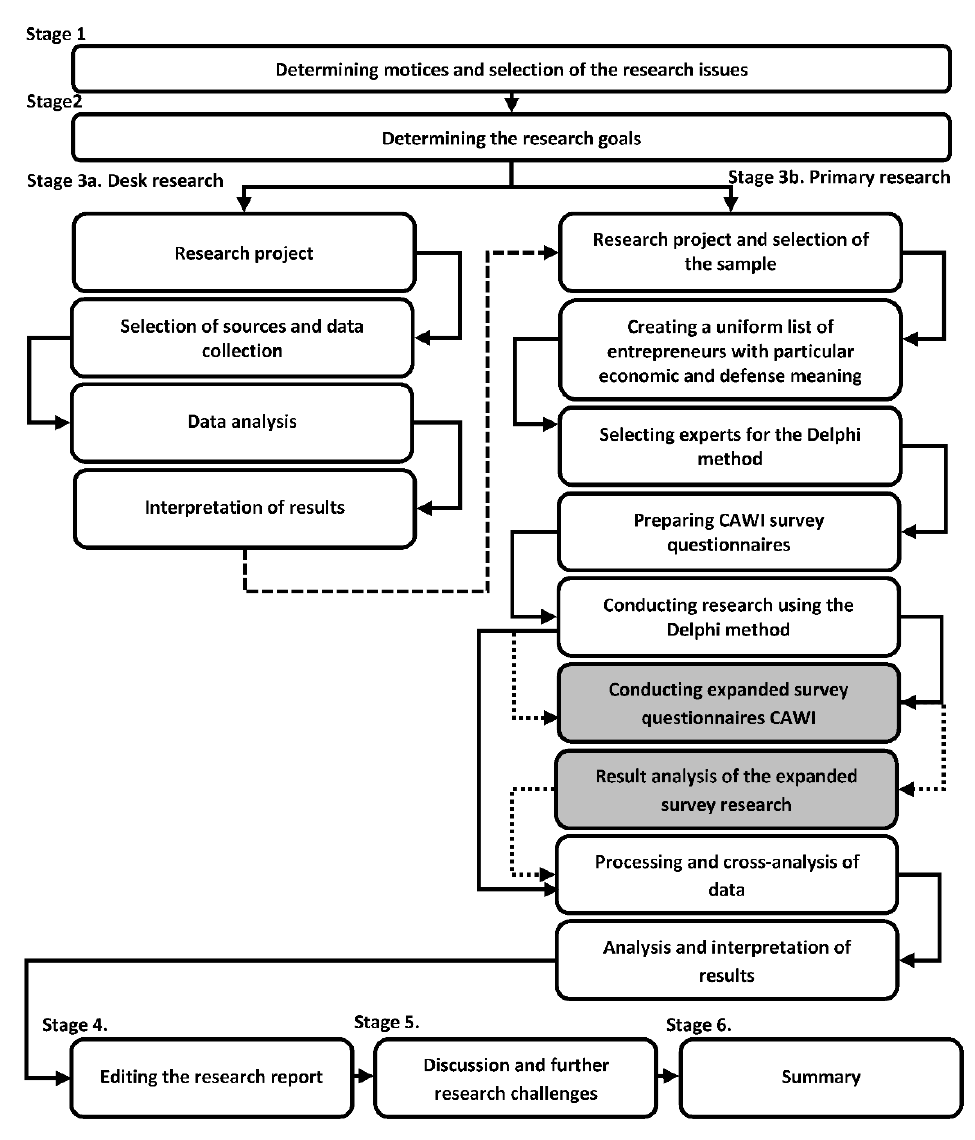
Figure 1. Scheme of the research process. Source: Own study, 2021.